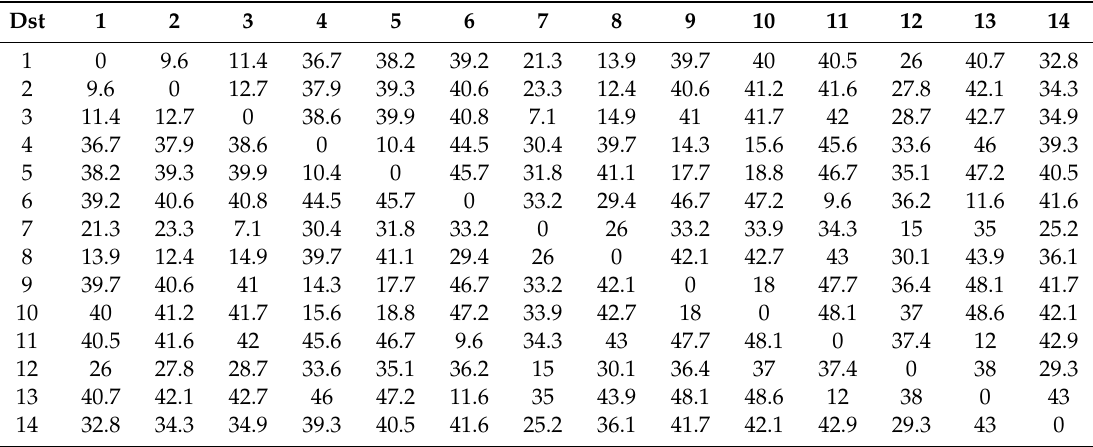
Table 3. Distance matrix of the 14 VPPs in the case